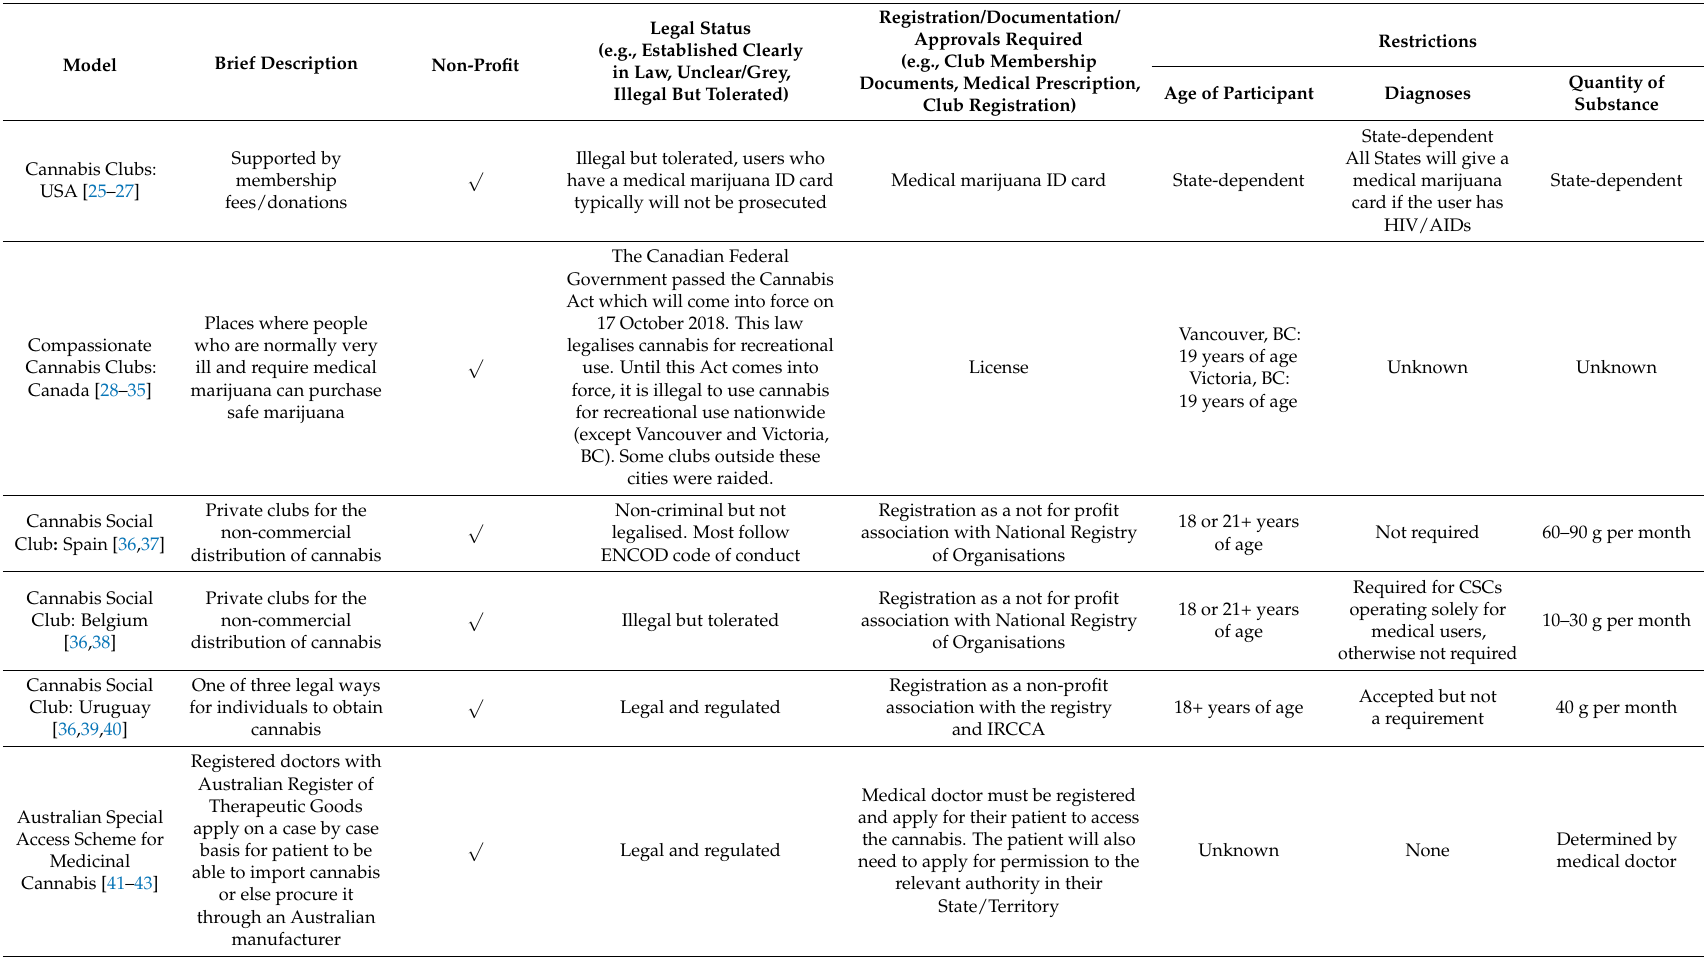
Table 1. Examples of the regulatory models (social club and special access scheme) for access to controlled substances (Cannabis and Kava).